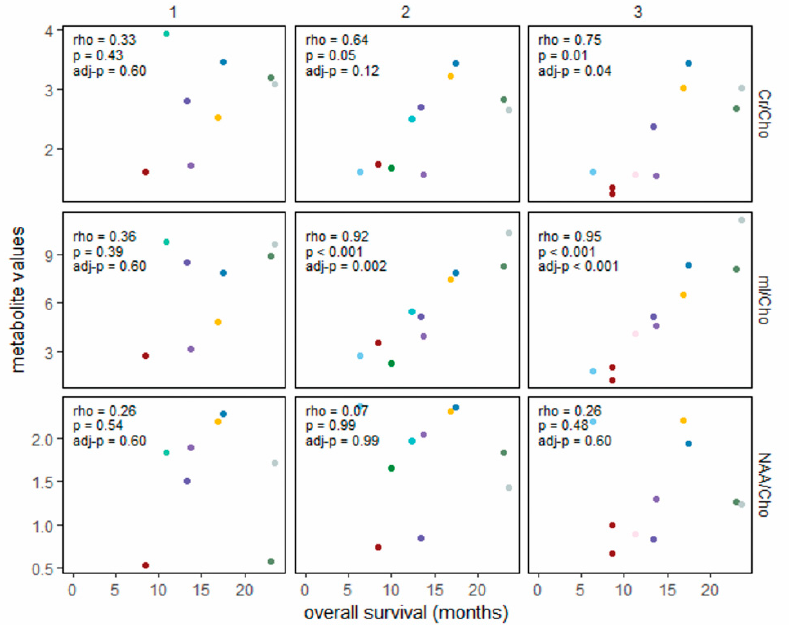
Figure 2. Association between metabolite ratios and overall survival in the vaccine cohort, grouped by timepoints relative to completion of RT (columns) (28 scans within 7.6 months of diagnosis in 12 patients). RT = irradiation with or without concurrent chemotherapy. Spearman rank-order correlations are shown for each panel, with Benjamini–Hochberg control of p -values to a false positive rate of 0.05 for all panels. Each color represents an individual patient. Timepoint 1 = post-RT and before vaccine therapy (1.9–3.8 months post-diagnosis); timepoint 2 = after 2–3 vaccine doses (3.9–5.2 months post-diagnosis); timepoint 3 = after 4–6 vaccine doses (5.3–7.6 months post-diagnosis). Table 2. Monthly rate of terminal decline for key metabolite ratios, excluding scans at diagnosis. Lin- ear mixed-effects (random intercept) models for each metabolite, fit separately for each study cohort. Within 6 Months of